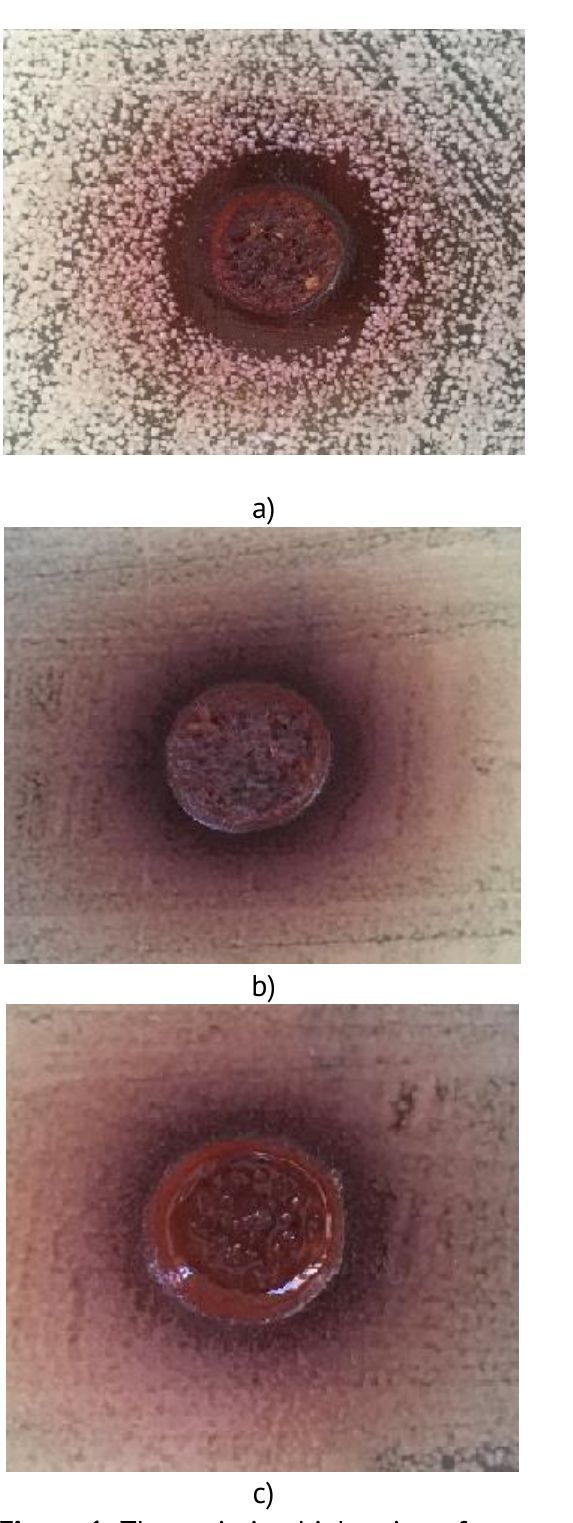
Figure 2. The antimicrobial action of hawthorn powders on: a) Staphylococcus aureus ; b) Escherichia coli ; c) Klebsiella